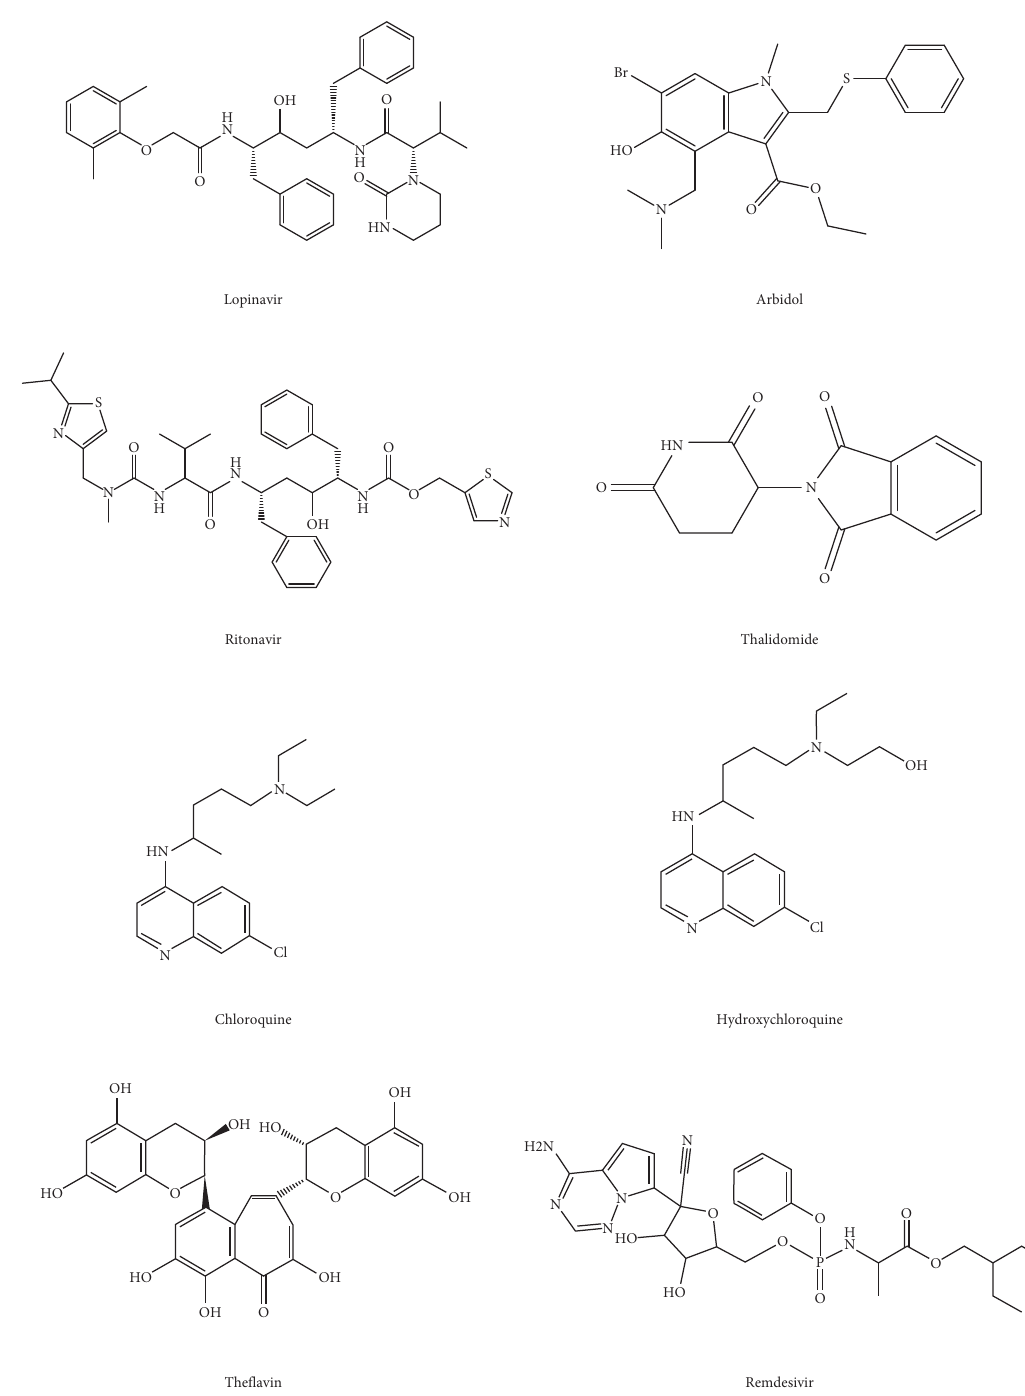
Figure 2: Antiviral drugs and their molecular